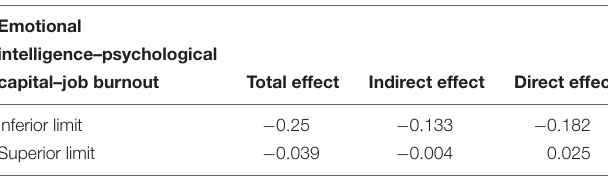
TABLE 8 | Test the mediating effect of psychological capital in the influence of emotional intelligence on job burnout.